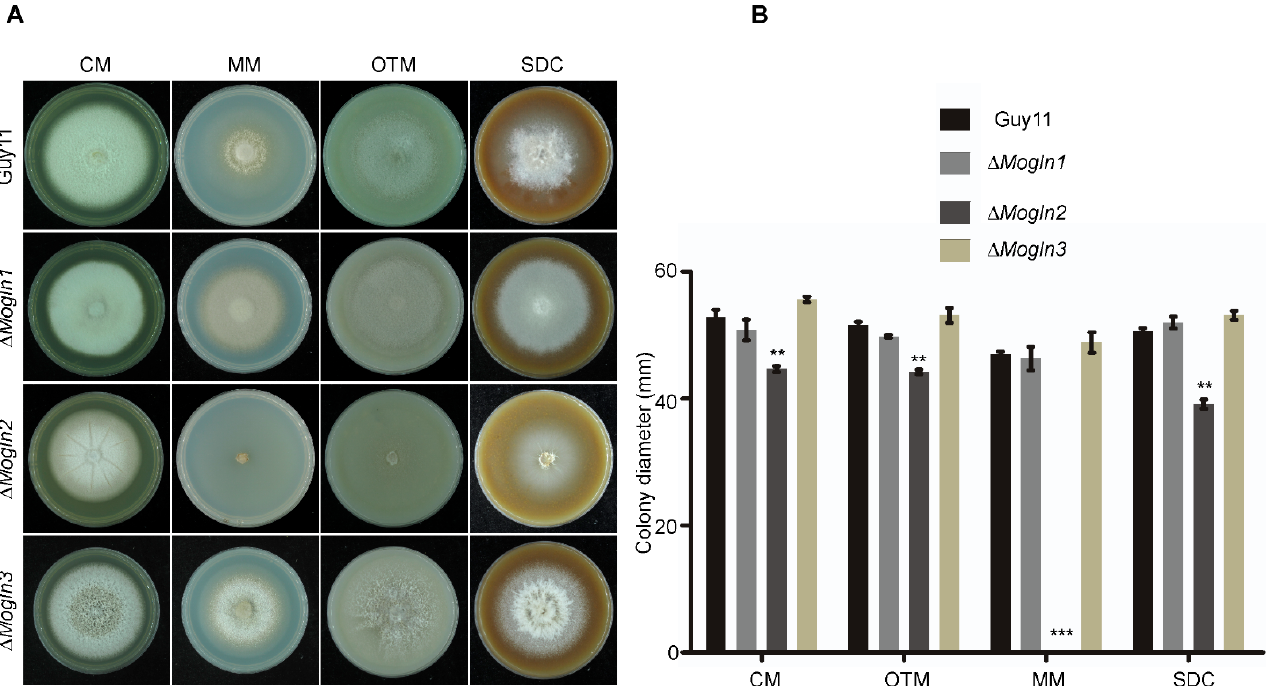
Figure 4. MoGLN2 is required for vegetative growth in M. oryzae . ( A ) Photographs showing radial and aerial hyphal growth of the wild-type (WT) and the three mutants. Mycelial plugs inoculated on CM, MM, OTM, and SDC were cultured in the dark at 28 °C, and photograph taken after eight days. ( B ) Bar graphs showing the difference in radial growth between the WT and the three MoGLN mutants. The error bar represents the standard deviation of three independent replicates, while the double asterisk shows significant difference (**, p < 0.01; ***, p < 0.001; one-way ANOVA was used to analyze data with Tukey’s multiple-comparison test in GraphPad Prism 8).